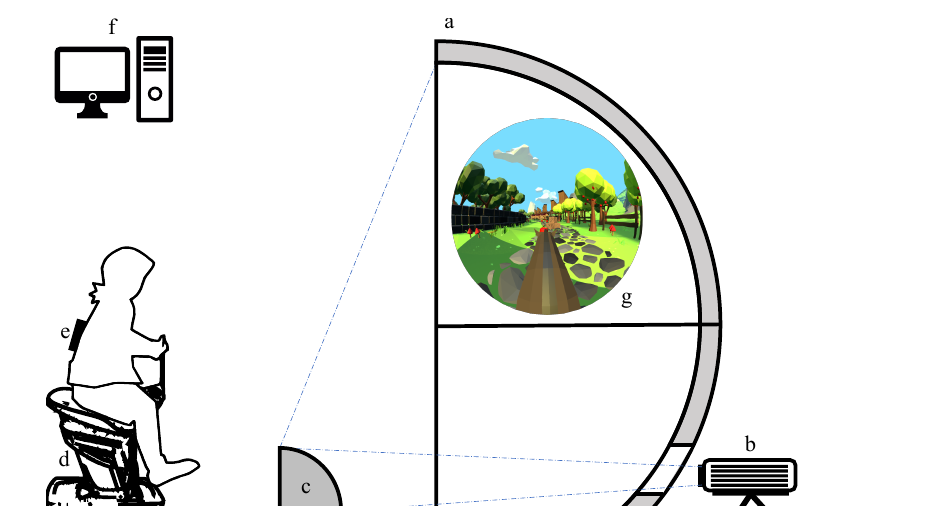
Figure 1. Hippotherapy simulator station: Dome-based VR equipment: ( a ) iDome, ( b ) Projector, ( c ) Spherical convex mirror. Hippotherapy device: ( d ) Horse riding simulator. Exergaming equipment: ( e ) Inertial sensors-based controller, ( f ) Laptop or PC to host exergaming content, and ( g ) Exergaming video game, Sirkus Apel